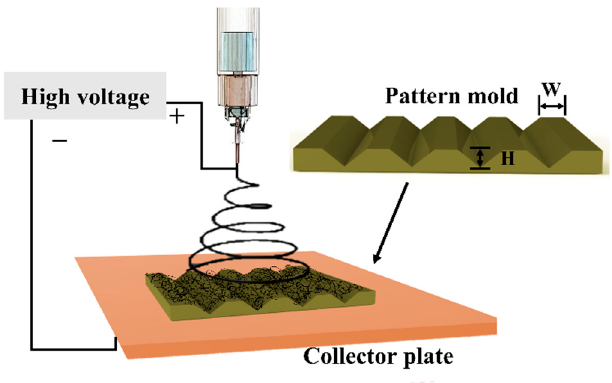
Figure 1. The electrospinning process for fabricating structural scaffold. The alphabet ‘H’ and ‘W’ represents the height of the triangular prism and width between each of the triangular prism, re- spectively.